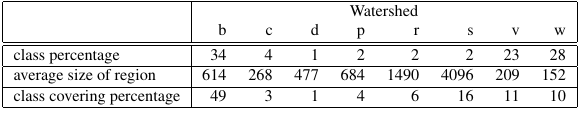
Table 3: Statistics of the percentage of each class label, the av- erage size of the region of each class, and the percentage of the image covered by each class for the baseline watershed segmen- tation on the eTRIMS 8-class dataset.